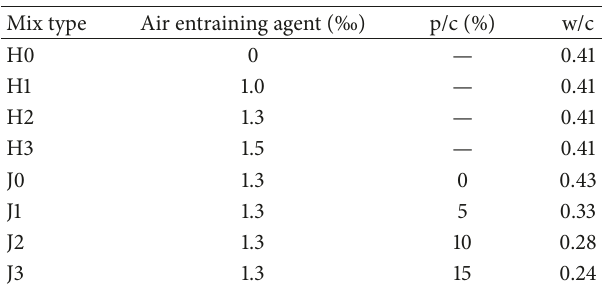
Table 4: Concrete mix design.